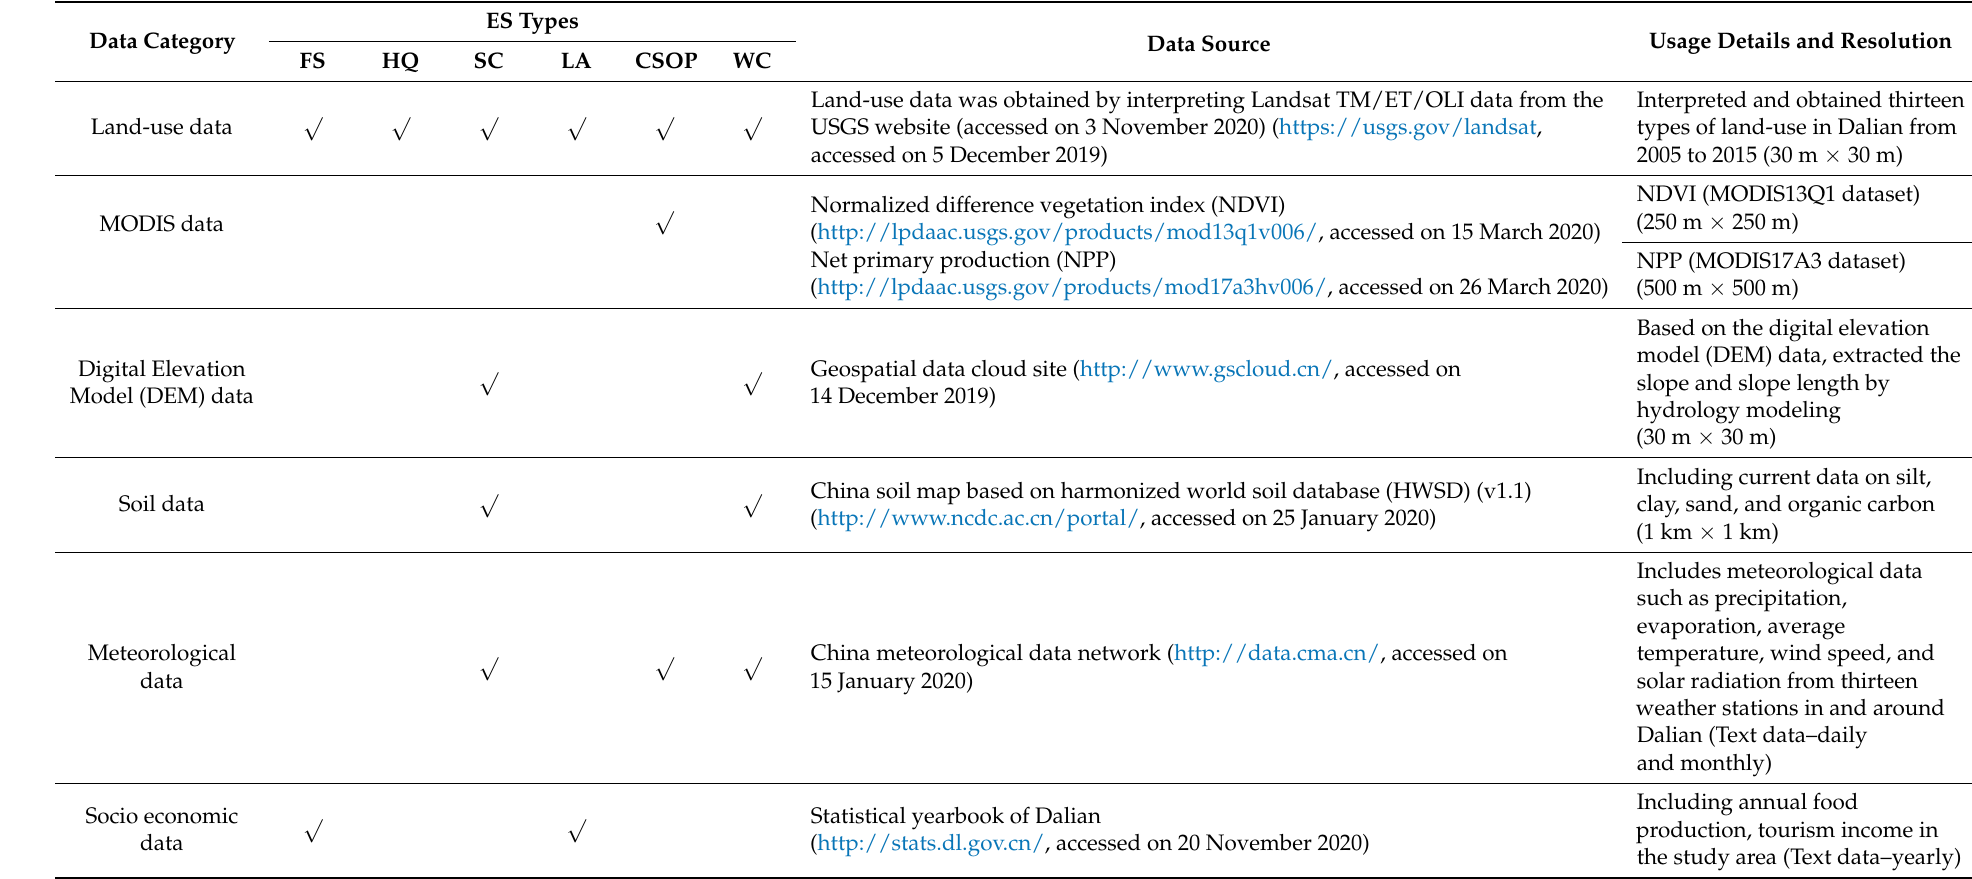
Table 1. Data sources for ES